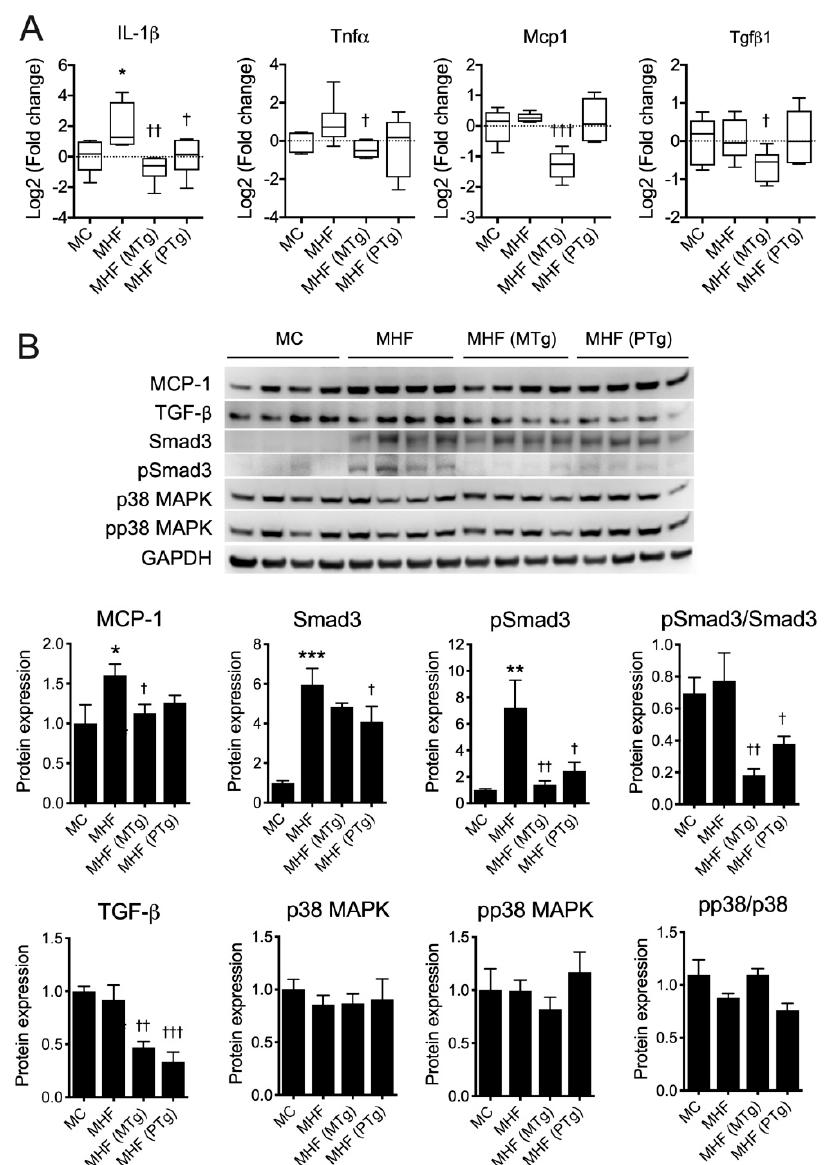
Figure 4. Parental SIRT1 overexpression attenuates inflammation in the MHF offspring’s liver. ( A ) mRNA expression and ( B ) protein expression of inflammatory markers ( n = 4–6) vs. MC: * p < 0.05, ** p < 0.01, *** p < 0.001; vs. MHF: † p < 0.05, †† p < 0.01, ††† p < 0.001.